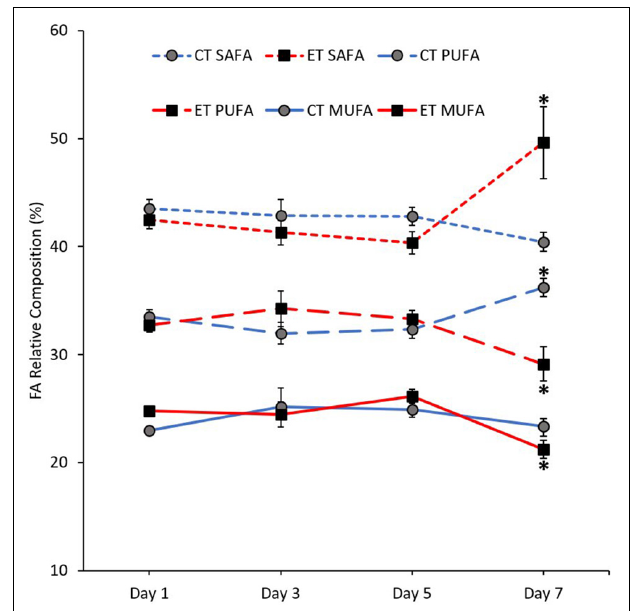
FIGURE 6 | Composition of fatty acid (FA) classes [saturated fatty acid (SAFA), monounsaturated fatty acid (MUFA), and polyunsaturated fatty acid (PUFA)] in coral samples from CT and ET during the experimental period. All data points are mean ± SE ( n = 9). Asterisk represents a significant difference ( p <